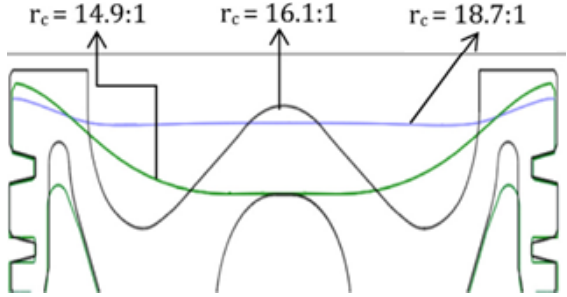
Fig. 12. Comparison of RCCI and classic CI engine piston with combus- tion chamber inside of it (reproduced from [31]) Form of combustion chamber in RCCI engine is funda- mentally different than in classical CI diesel engine. The swirl ratio of air-fuel mixture must be higher, surface of itself will be softer. In the Fig. 13 is shown the cross section of the piston where the sharpest edges of the combustion chamber are colored by the red circles.